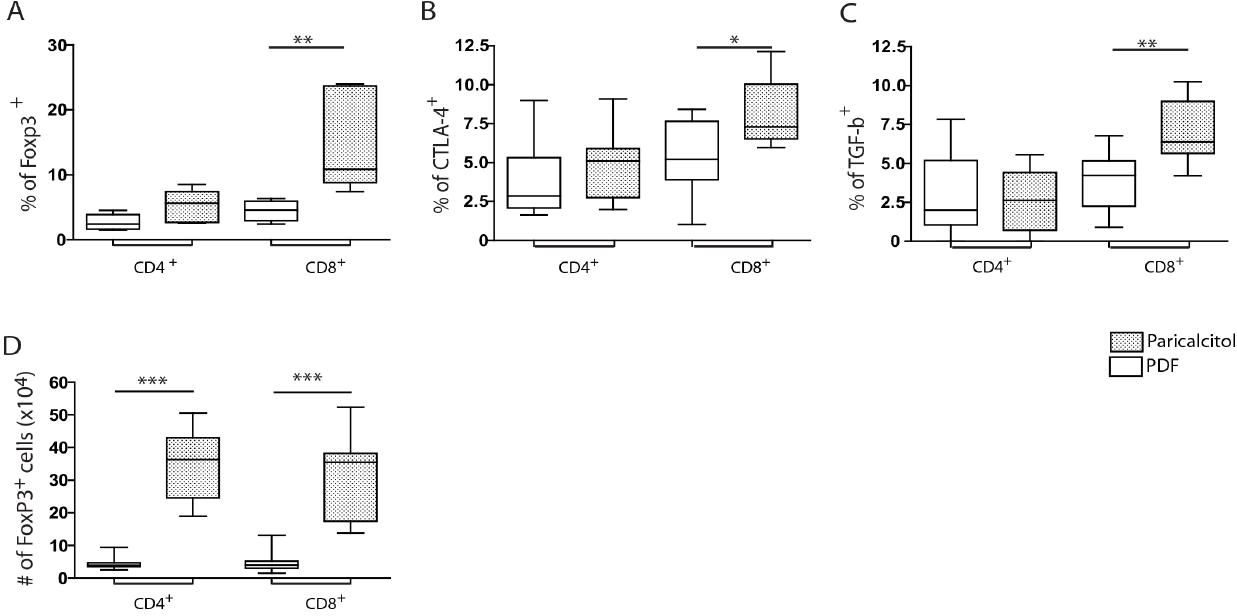
Figure 4. Paricalcitol induced the recruitment of regulatory CD8 + T cells into the peritoneal cavity. Paricalcitol (dashed box) tended to increase the frequency of CD4 + T cells expressing Foxp-3 (A), but not CTLA-4 (B) or membrane TGF- b (C). Paricalcitol increased the frequency of CD8 + T cells expressing Foxp-3 (A), CTLA-4 (B) and membrane TGF- b (C) compared with the PDF-group (white box). n $ 9 in each group. Paricalcitol treated group had higher number of CD4 + CD8 + T cells expressing Foxp-3 than PDF group (D). Statistical significance was determined using the Mann- Whitney test. * P , .05; ** P , .01; *** P , .001.